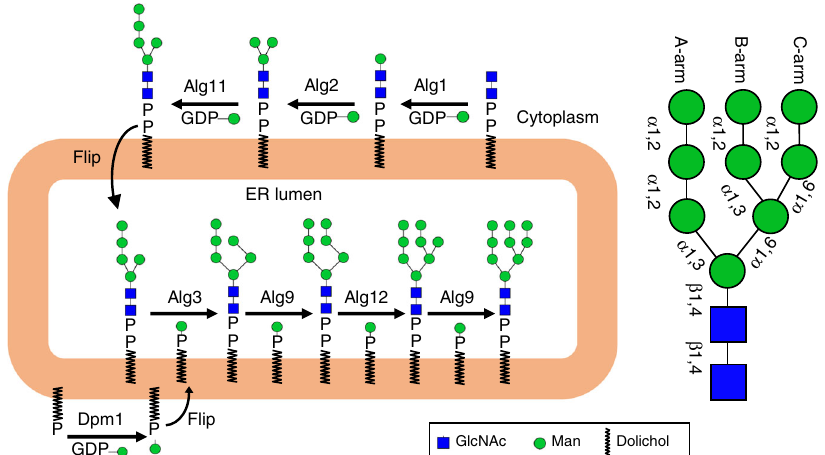
Fig. 1 Mannosylation in the eukaryotic LLO biosynthesis pathway. Alg mannosyltransferases (MTases) catalyze formation of M9GN2-PP-Dol by sequentially adding mannoses to GN2-PP-Dol. Cytosolic reactions use the nucleotide sugar GDP-Man donor, while luminal enzymes use Man-P-Dol, synthesized by Dpm1. Linkages of each sugar are indicated on the right, as are the A, B and C arms of the triantennary